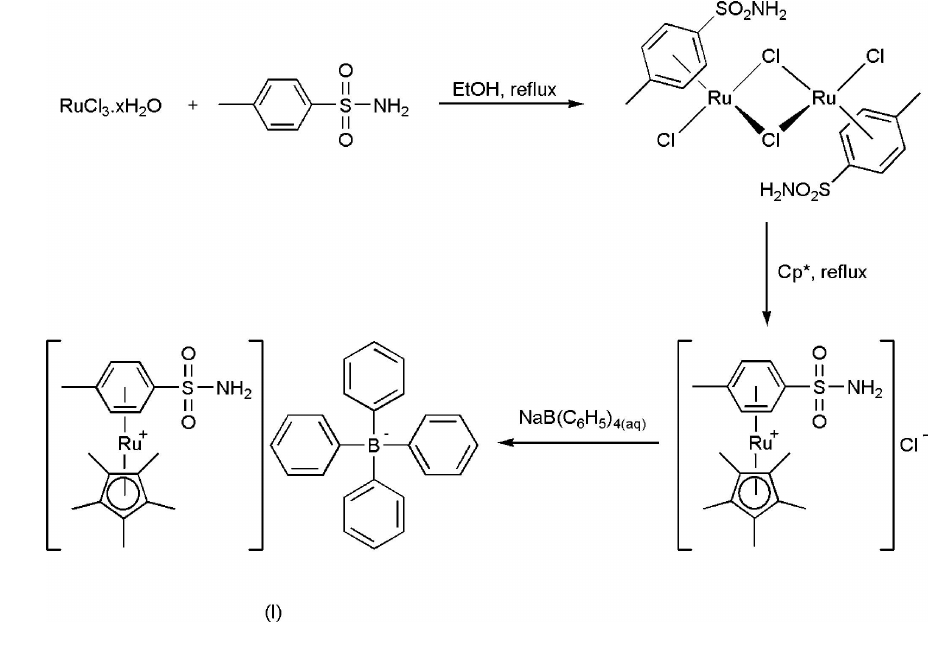
Figure 2 Synthetic route for (I). ( η 5 -Pentamethylcyclopentadienyl)( η 6 - p - toluenesulfonamide)ruthenium(II)